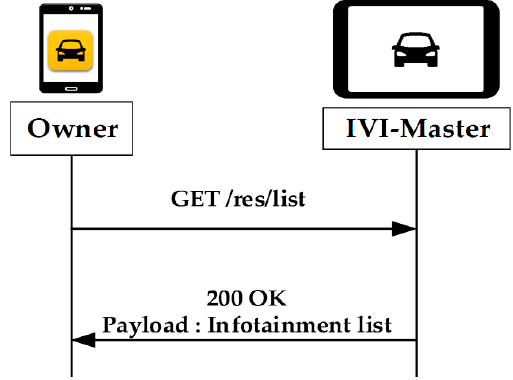
Figure 8. Request of the resource list by owner.